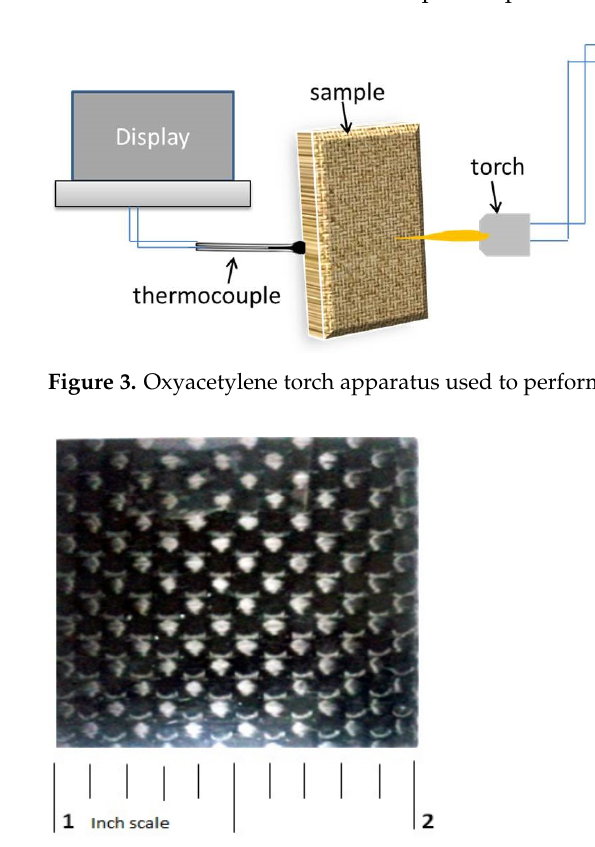
Figure 2. Thermal conductivity test arrangement.